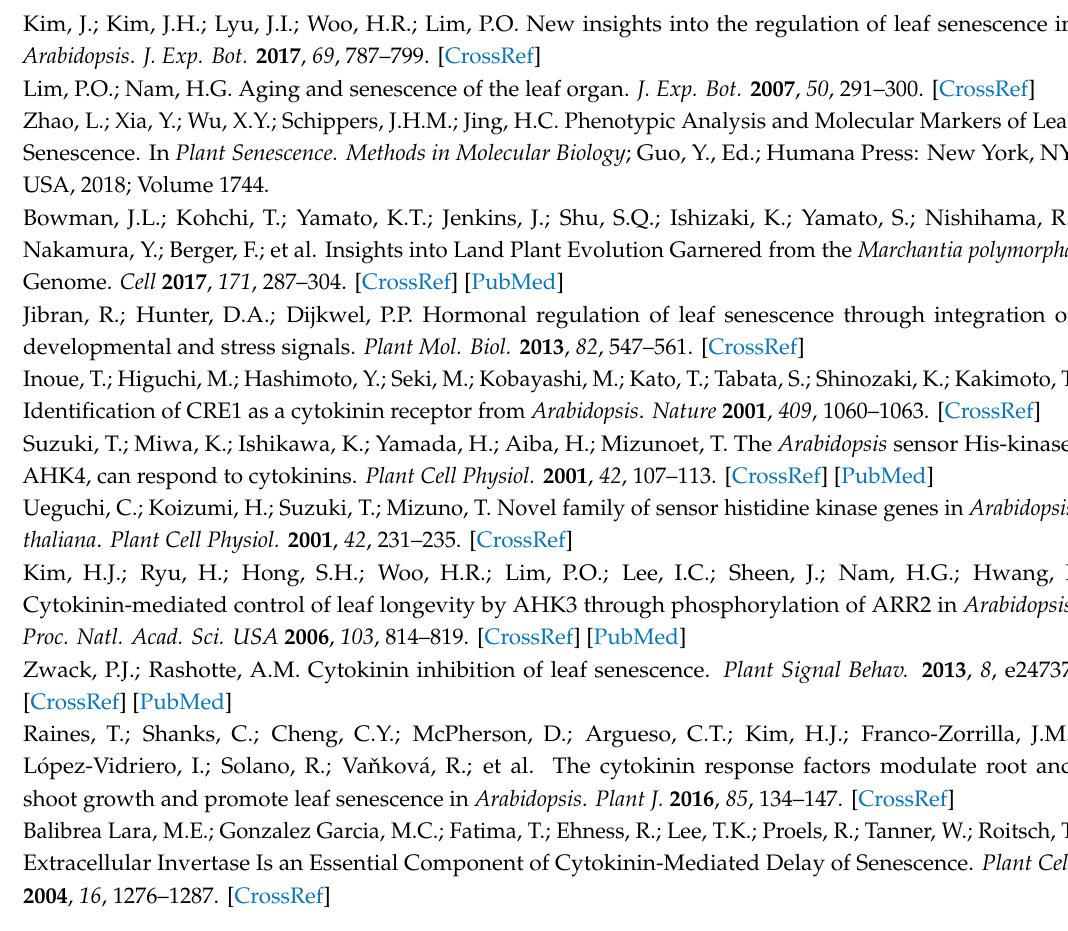
Figure S1: The genotyping of the hybrid Arabidopsis ahk3-3 / SSPPox was confirmed by semi-quantitative RT-PCR. Figure S2: Reciprocal comparisons between ahk3-3 / SSPPox , ahk3-3 , SSPPox , and WT on rosette diameters, plant height, bolting time, and flowering time. Table S1: Primers used in this